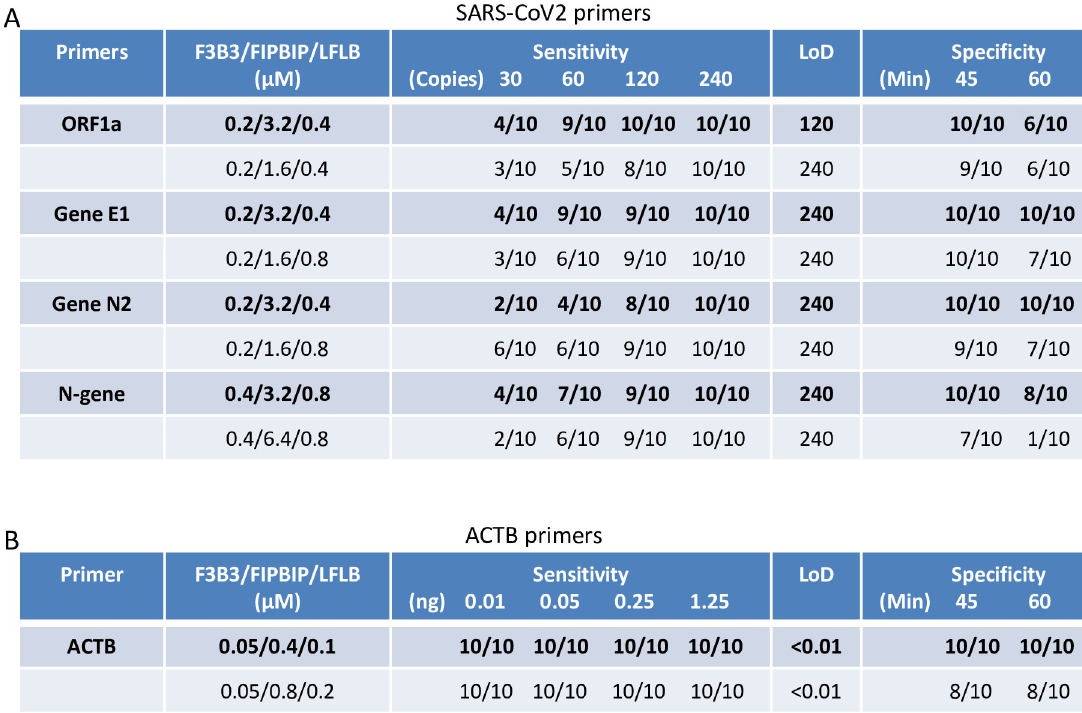
Fig 2. Evaluation of the optimized primer concentrations based on limit of detection and specificity. (A) ORF1a, Gene E1, Gene N2 and N-gene primers were assessed at the indicated conditions. Each condition was evaluated with 10 replicates. (B) ACTB primers were evaluated under the indicated conditions. Sensitivity, the percentage of replicates with SARS-CoV-2 RNA or human RNA showing amplifications; Specificity, the percentage of no template controls without amplifications; TTR, time to results (minutes); LoD, limit of detection; Error bars represent mean ± standard